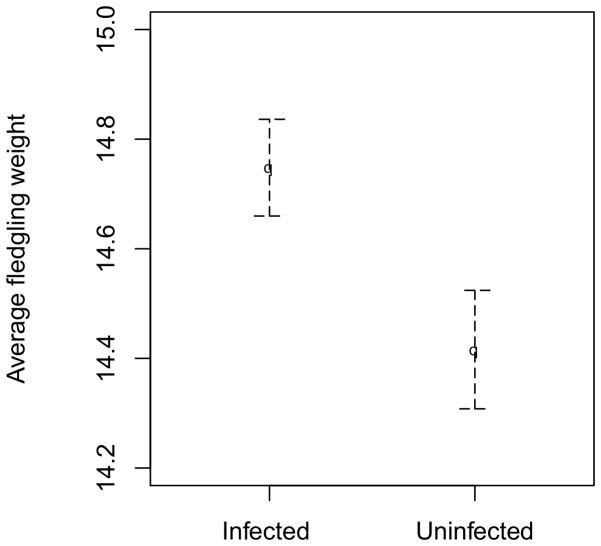
Comparison of fledgling weight of Haemosporidia-infected and uninfected collared flycatcher females.Fledglings of infected females are on average heavier than offspring of uninfected females. The plot dots show means for respective groups of females, error bars indicate 1 standard error from the mean.